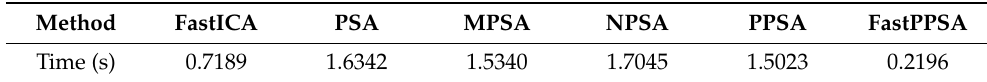
Table 8. Running time evaluation of BSS